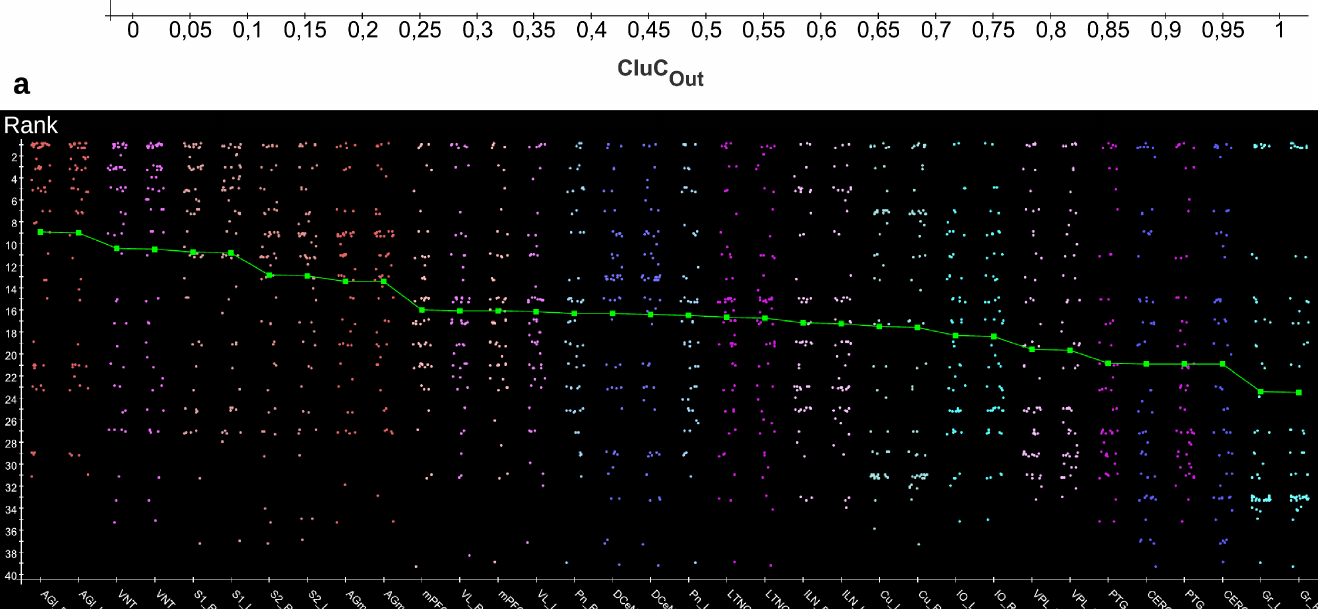
Fig 4. Relation of average concentrations and local network parameters. a) The correlation c = 0.726 of average concentrations ( AvgGEMEx ) and the CluC coefficient. b) Each point indicates the rank of a local network parameter of a region. The green curve represents the mean ranks. The colors correspond to the color assignments to the considered regions of the network, which were introduced in Fig 1 in the form of an adjacency matrix. determined for each variation of parameters. The average cross-correlations over all variations of parameters for each pair of regions is displayed as an average cross-correlation matrix. For the GM model the parameters reaction constants for the reaction substances A ( rateA ) and I ( rateI ) as well as the decay rates for the substance A ( muA ) and I ( muI ) were investigated over a range from 0.004 to 0.016 with a step size of 0.004. 256 simulations were performed (Fig 5).